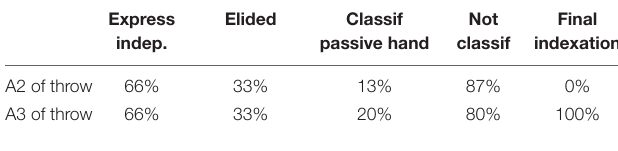
TABLE 6 | Comparison of A2 and A3 of throw. Express